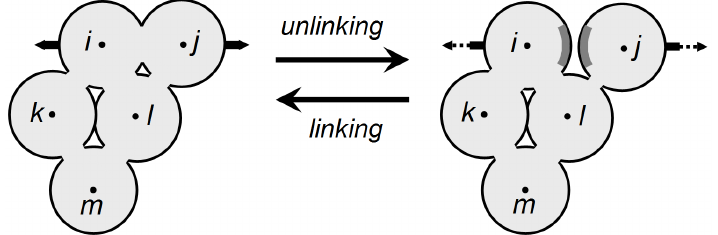
Figure 1: Schematic presentation of switching between linked (at the left) and unlinked (at the right) states of the pair of discrete elements i and j .